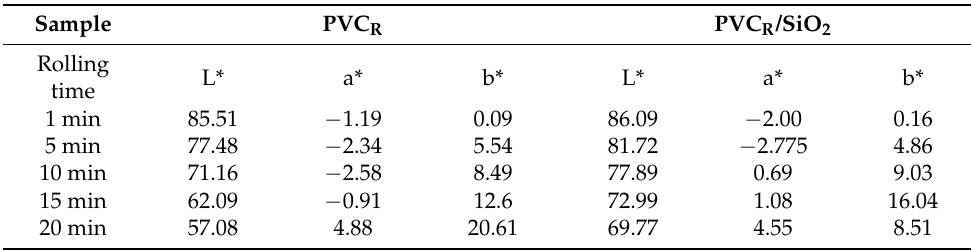
Table 3. Values of lightness L* and a*, b* coordinates for reference PVC without SiO 2 (PVC R ) and with SiO 2 (PVC R /SiO 2